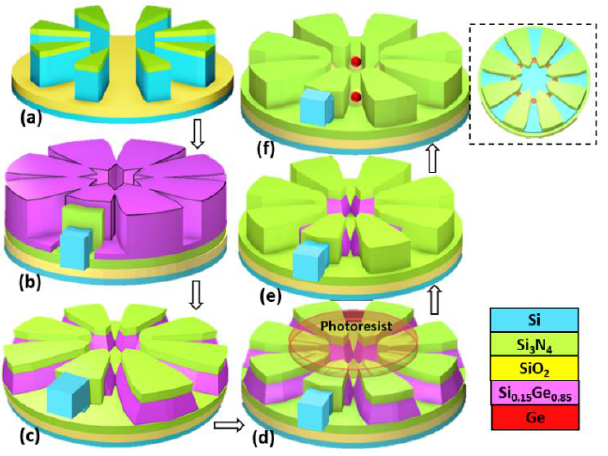
Figure 1. Process flow diagrams showing the fabrication of multiple QDs embedded within SiO 2 /Si 3 N 4 matrices via the thermal oxidation of SiGe spacer islands at designated included-angle locations of Si 3 N 4 /c-Si ridges. ( a ) Lithographically patterned Si 3 N 4 /c-Si fanout ridges on top of an SOI substrate. ( b ) Next, sequential deposition of Si 3 N 4 and poly-Si 0.85 Ge 0.15 layers conformally encap- sulates the Si 3 N 4 /c-Si ridges. ( c ) Symmetrical spacer stripes of poly-Si 0.85 Ge 0.15 are subsequently fab- ricated at each sidewall of the Si 3 N 4 /c-Si ridges by a direct etch back process. ( d ) Lithographic-pat- terning shadowing the central regions of the designed fanout ridges in combination with ( e ) etching processes are conducted to define the lengths of the poly-Si 0.85 Ge 0.15 spacer islands. ( f ) Next, spherical Ge QDs are formed at each included-angle location of the nano-patterned Si 3 N 4 /c-Si ridges sidewall by thermal oxidation. The inset is the plan-view sketch showing the simultaneous formation of mul- tiple Ge QDs at each included-angle locations of Si 3 N 4 /c-Si ridges by design.